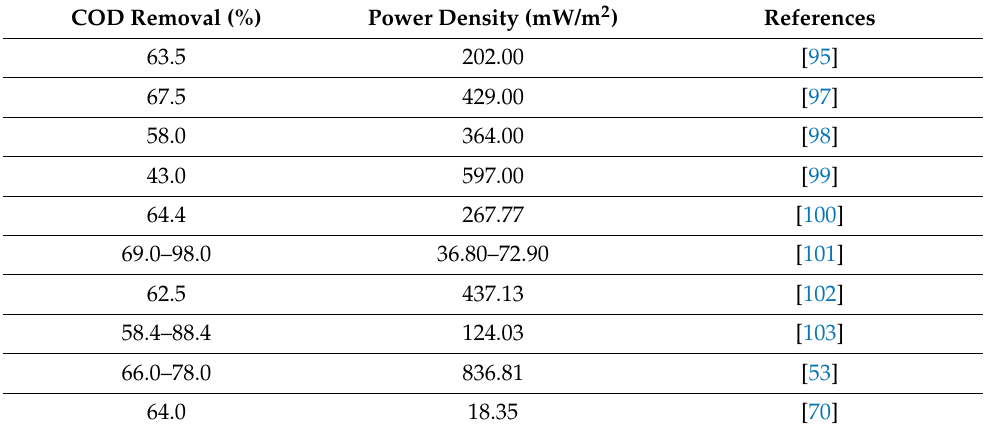
Table 5. Power generation in processing from distillery waste in bioelectrochemical-based